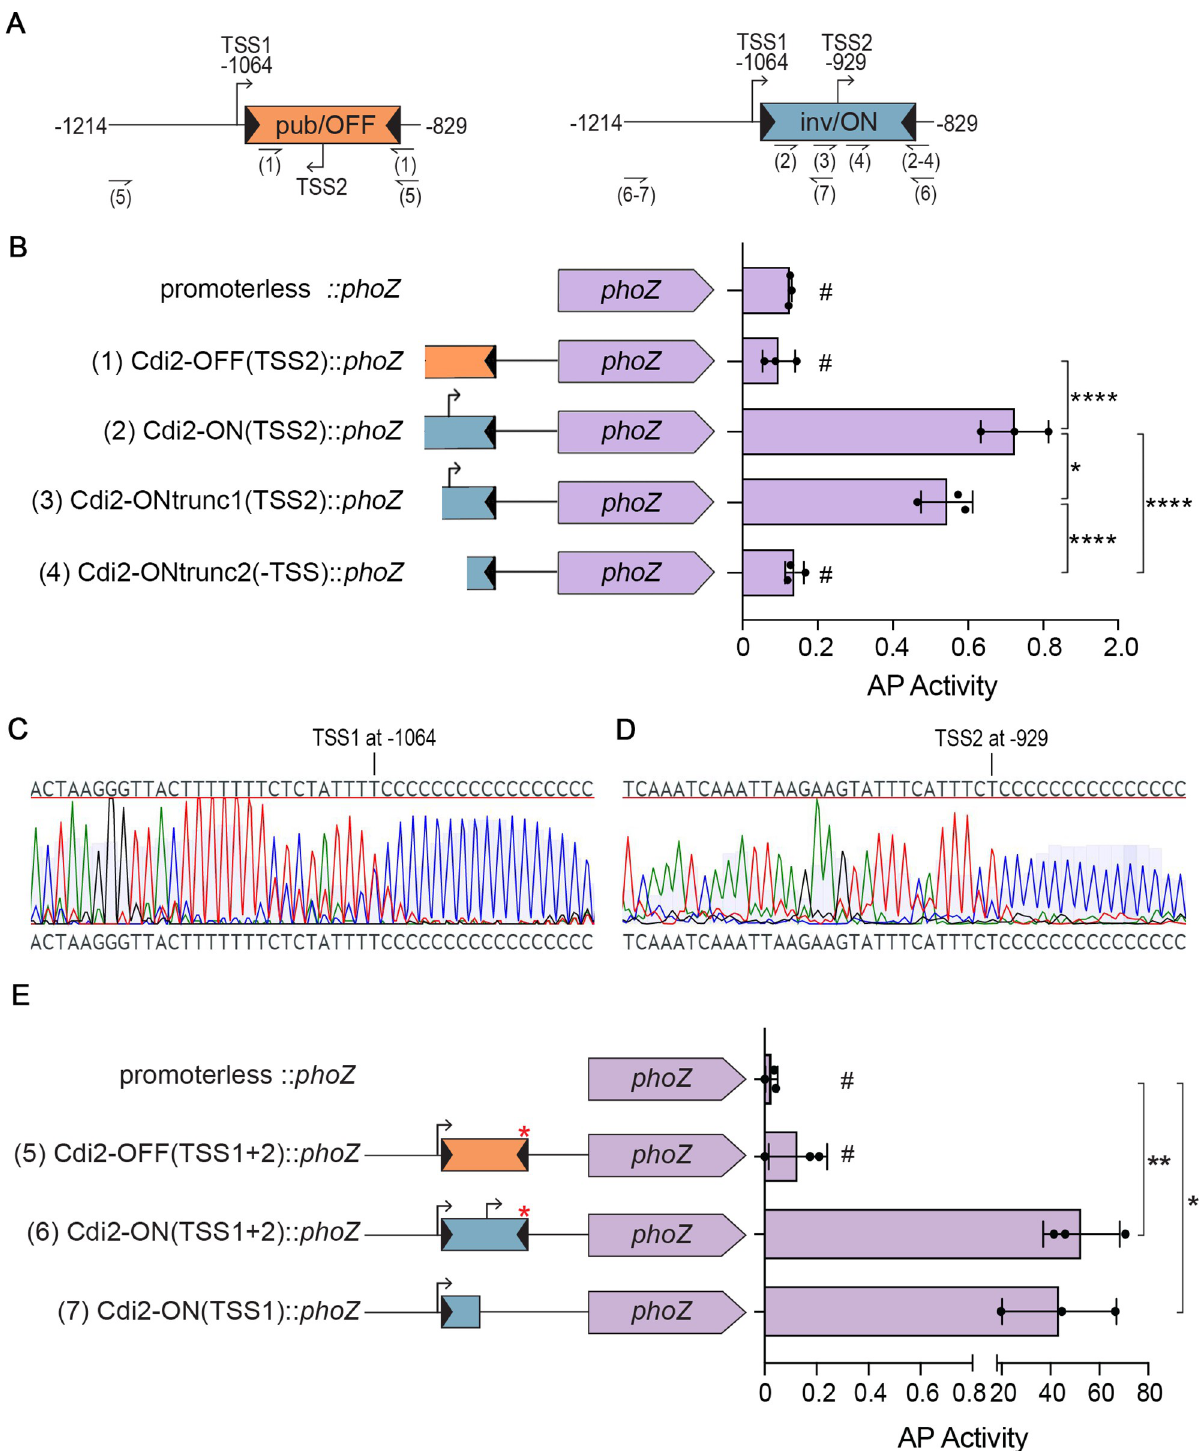
Fig 3. The pdcB switch contains an invertible promoter. (A) Diagrams of the pdcB switch in the OFF and ON orientations with TSS1 and TSS2 positions indicated relative to the pdcB start codon. Positions of primers used to construct the fusions to phoZ in (B) and (E) are indicated by half arrows; numbers in parentheses match the primers used with the corresponding plasmid construct. (B) Alkaline phosphatase (AP) assay using C . difficile strains with plasmid-borne transcriptional fusions to phoZ . Promoterless phoZ was used as control. (C,D) Chromatographs of the Sanger sequencing results obtained by 5’ RACE from (C) wild-type R20291 and (D) R20291 carrying the Cdi2-ON:: phoZ reporter. TSS1 and TSS2 were